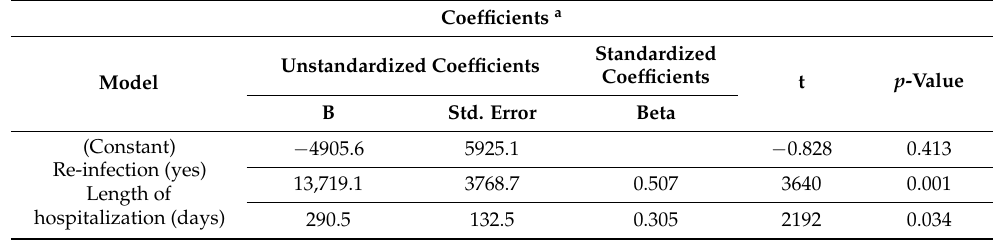
Table 3. Stepwise multiple linear analysis between antibody titers and significant